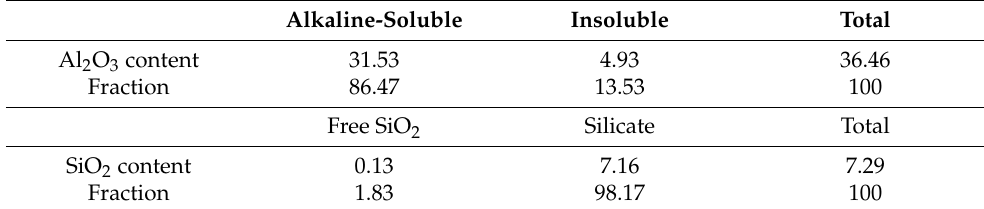
Table 4. Occurrence of alumina and silica in the MPRS